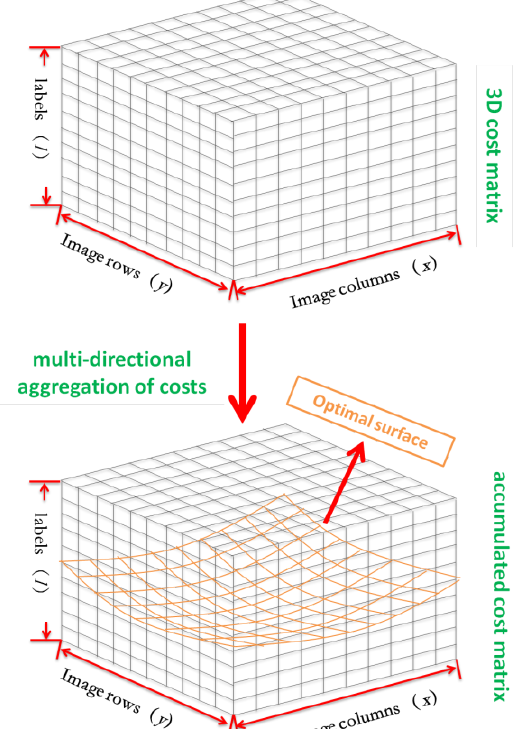
Figure 2. Flowchart of semi-global optimization